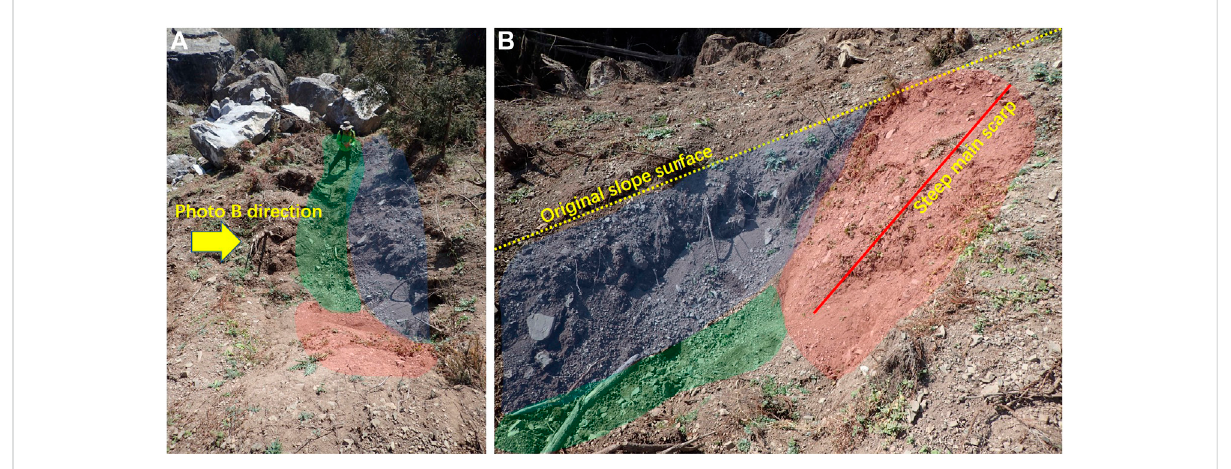
FIGURE 8 Slope toe cutting by rockfall impact: (A) view toward slope toe and (B) side view.